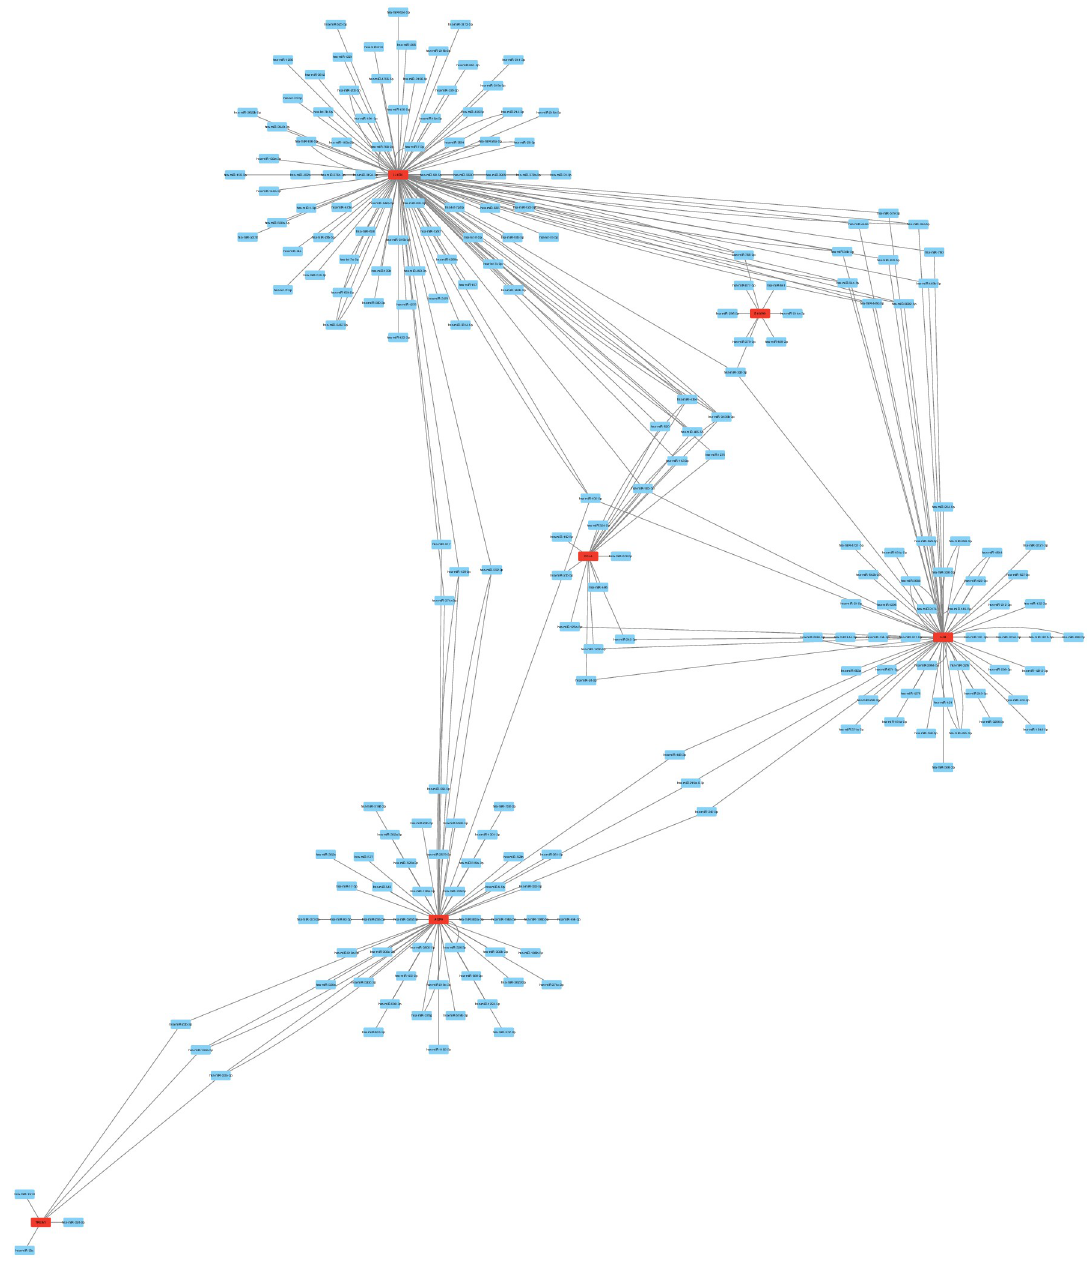
Fig 6. The mRNA-miRNA co-expression network. The mRNA-miRNA co-expression network was designed using Cytoscape. In a network, hub genes and miRNA targets are co-expressed together. TREM1 contains just six target miRNAs, compared to IL1RN’s dozens of miRNAs. The nodes represent mRNA and miRNA, while the edges represent the relationship between mRNA and miRNA interaction.